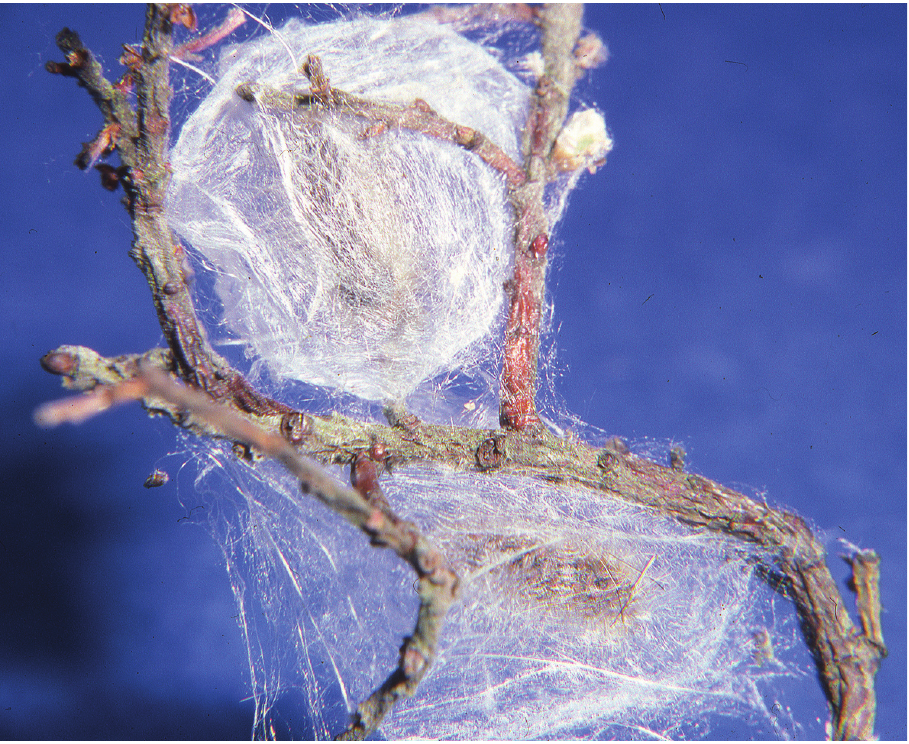
Figure 257. Aleiodes pallidator (Thunberg), England, penultimate instar mummies in precocious pseu- dococoons of Leucoma salicis